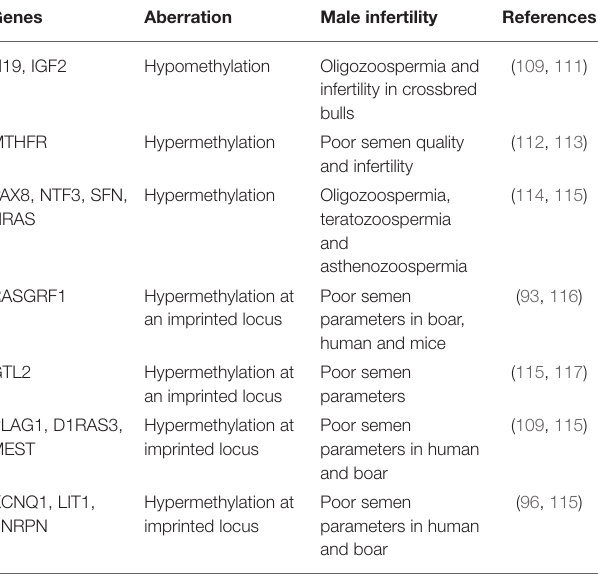
TABLE 1 | Methylation status of selected genes in relation to